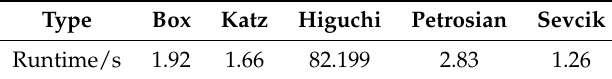
Table 2. Characteristic complexity evaluation.